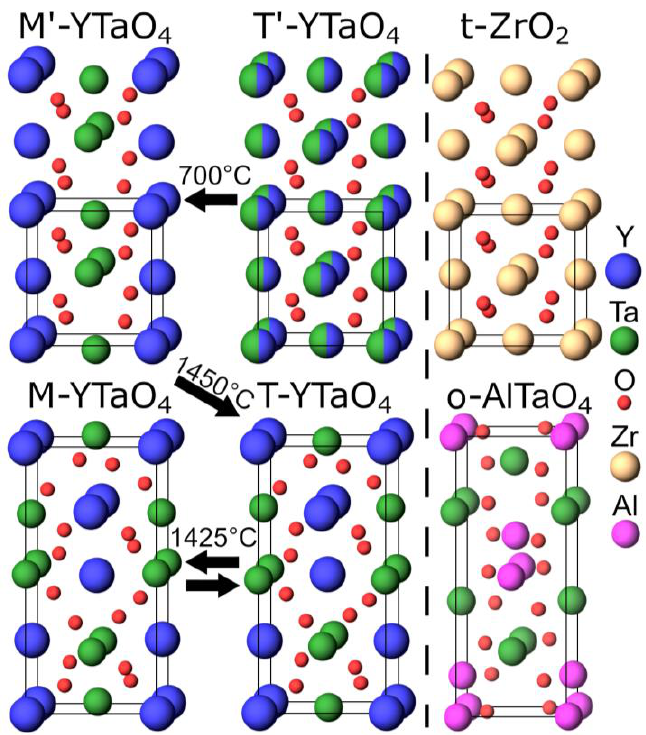
Figure 1. Structures of M‘-, M-, T‘-, T-YTaO 4 , t-ZrO 2 , and o-AlTaO 4 phases with indicated transi- tion pathways and temperatures based on experimental findings by [8,12,15].